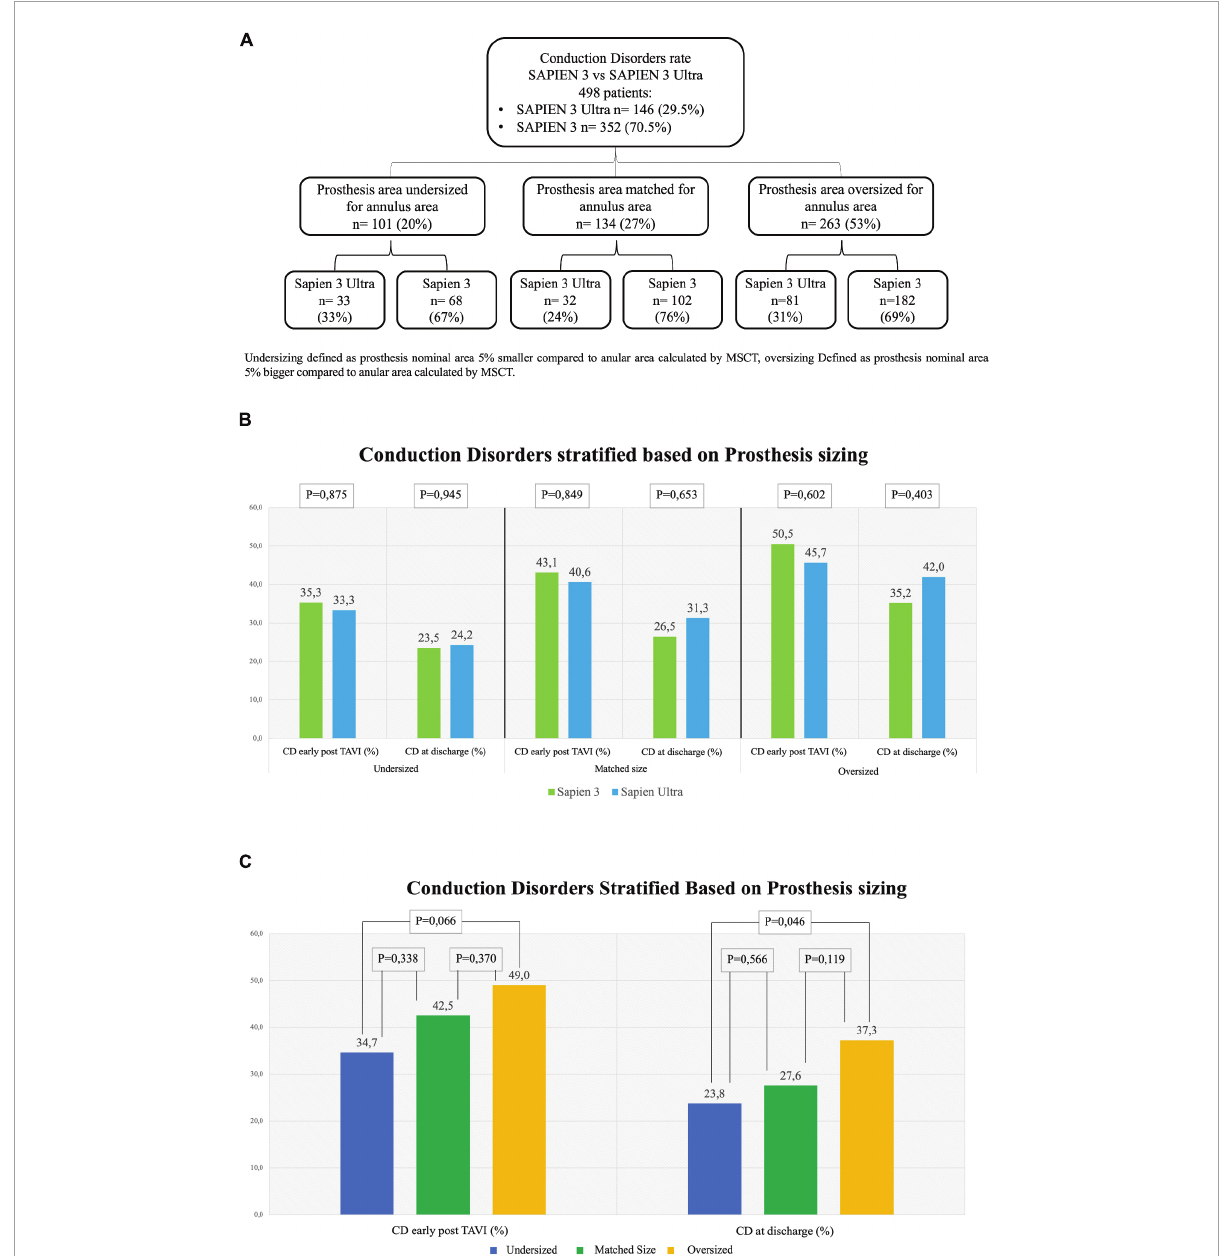
FIGURE4 Rate of conduction disorders stratified based on prosthesis size. (A) Flowchart of stratification. Undersizing defined as prosthesis nominal area 5% smaller than the annular area calculated by multi-slice computed tomography (MSCT). Oversizing defined as prosthesis nominal area 5% bigger than the annular area calculated by MSCT. (B) Conduction disorders (CD) rate early after TAVI in undersized prostheses (left graph), in matched-sized prostheses (central graph) and in oversized prostheses (right graph). (C) CD rate based on prosthesis sizing combining together the two generations of valves S3 and S3U early post procedure (left) and at discharge (right). Dark Blue: Undersized group, Dark Green: Normosized group, Yellow: Oversized